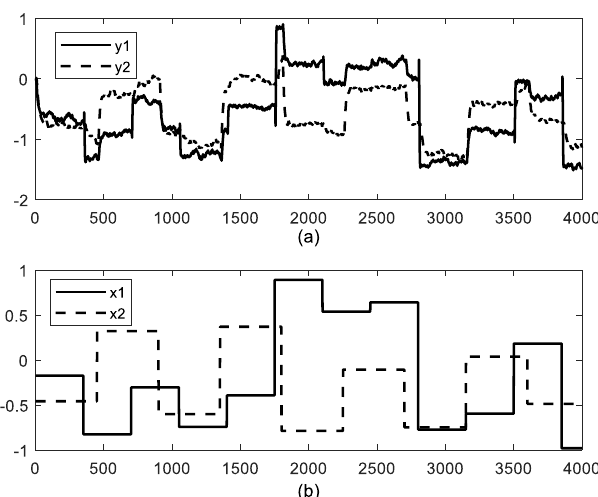
Figure 6. Input and output data to verify the system: ( a ) output data; ( b ) input data.